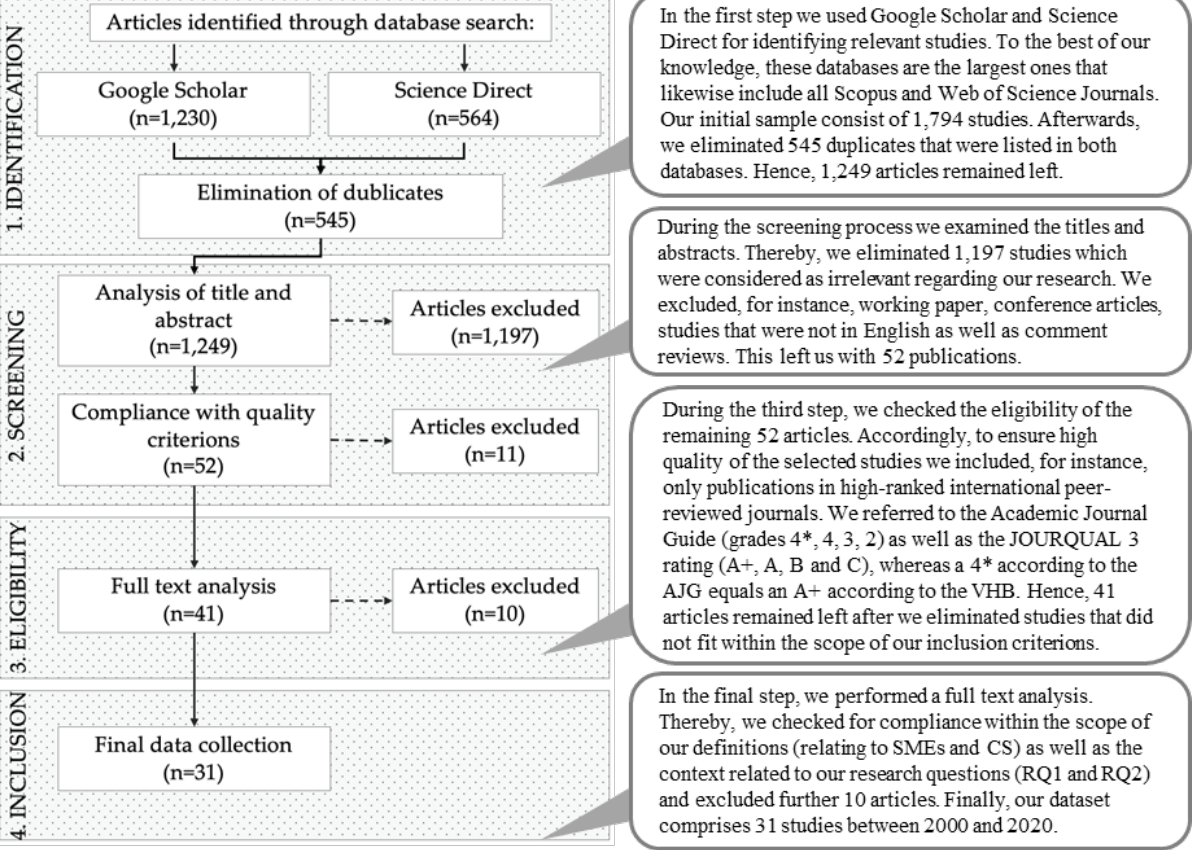
Figure 2. Selection process. Note: own depiction according to the PRISMA framework (Moher et al. 2009).